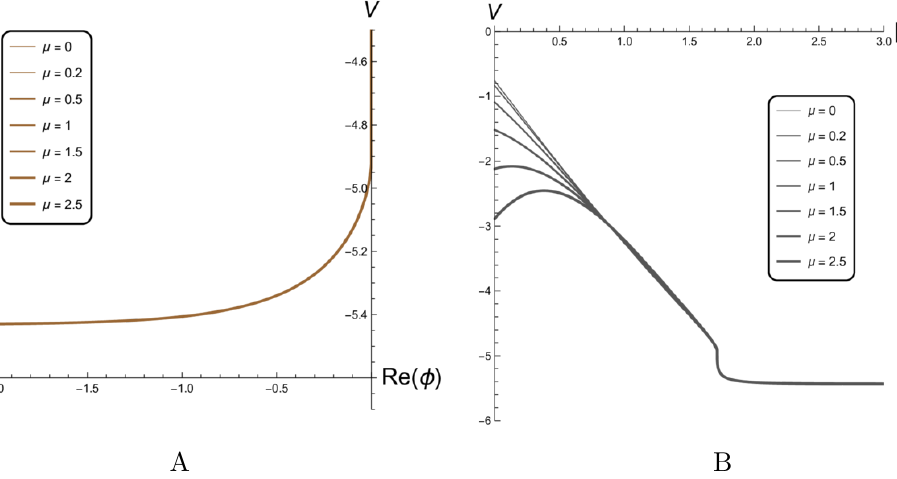
A B (cid:0) (cid:1) Figure 8 . Scalar potential V Re( (cid:30) ) (A) and V ( j (cid:30) j ) (B) for (cid:23) = 4 : 5, z h = 1, c = 1 and di(cid:11)erent (cid:22) under horizon, i.e. 0 < z <